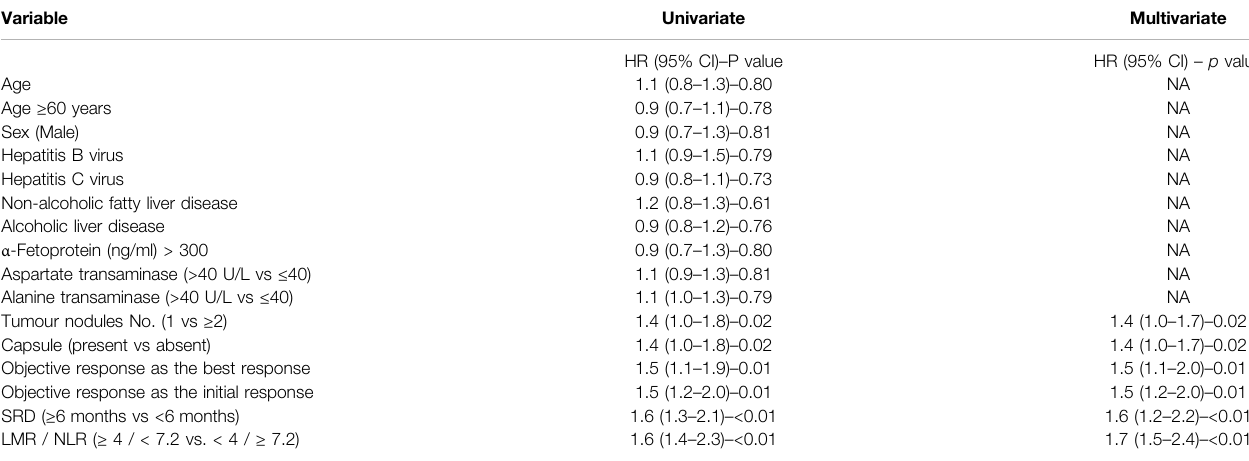
TABLE 4 | Factors predicting successful downstaging. Variable